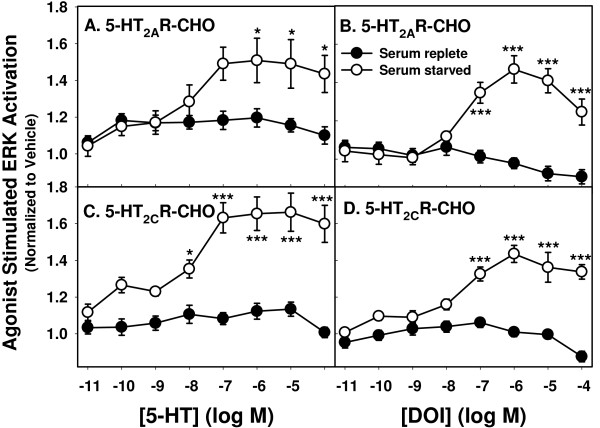
Ligand concentration and serum preincubation dependence on ERK activation in 5-HT2AR- and 5-HT2CR-CHO cells. 5-HT2AR- (A and B) and 5-HT2CR-CHO (C and D) cells plated at 16,000 cells/well for 24 hrs were preincubated in serum-replete medium (closed circles) or serum-free medium (open circles) overnight, followed by stimulation with vehicle (PBS) or indicated concentrations of 5-HT or DOI for 5 min. Levels of pERK were determined by plate immunoassay and normalized to cell number with crystal violet staining. Points represent data combined from three independent experiments (n = 5-6/experiment) normalized to vehicle control. * p < .05, ** p < 0.001 vs. vehicle.